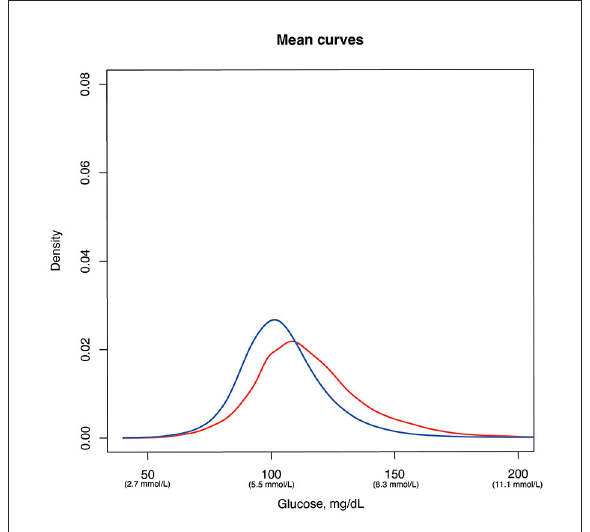
FIGURE3 Univariate density distributions of continuous glucose monitoring data in subjects with diabetes (red line) and without diabetes (blue